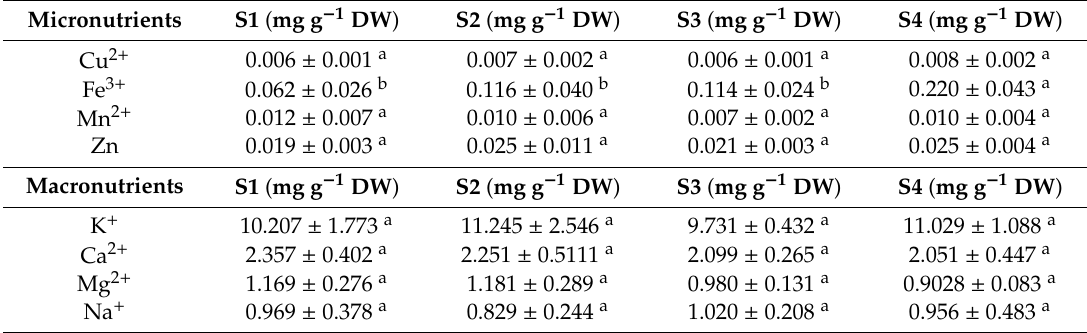
Table 1. Metal quantification during Pleroma raddianum flower development. S1—buds (day 0),